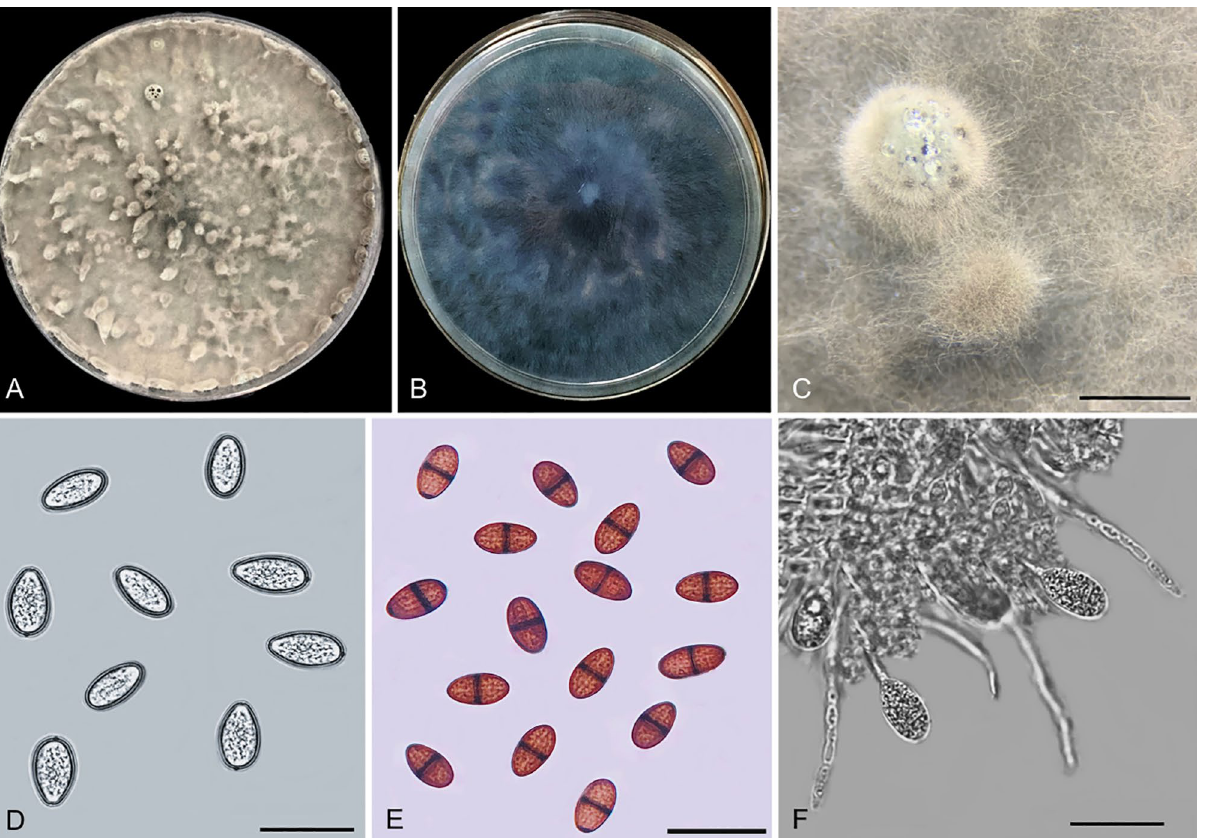
Figure 1. Morphological characteristics of Lasiodiplodia sp. recovered from diseased leaves, stem, and pods of Theobroma cacao . ( A ) Upper view of the colony appearance, ( B ) Reverse view colony appearance, ( C ) Conidiomata, ( D ) Immature conidia, ( E ) Mature conidia, ( F ) Conidiogenous cells and paraphyses. Scale bars: ( C ) = 1 mm; ( D – F ) = 50